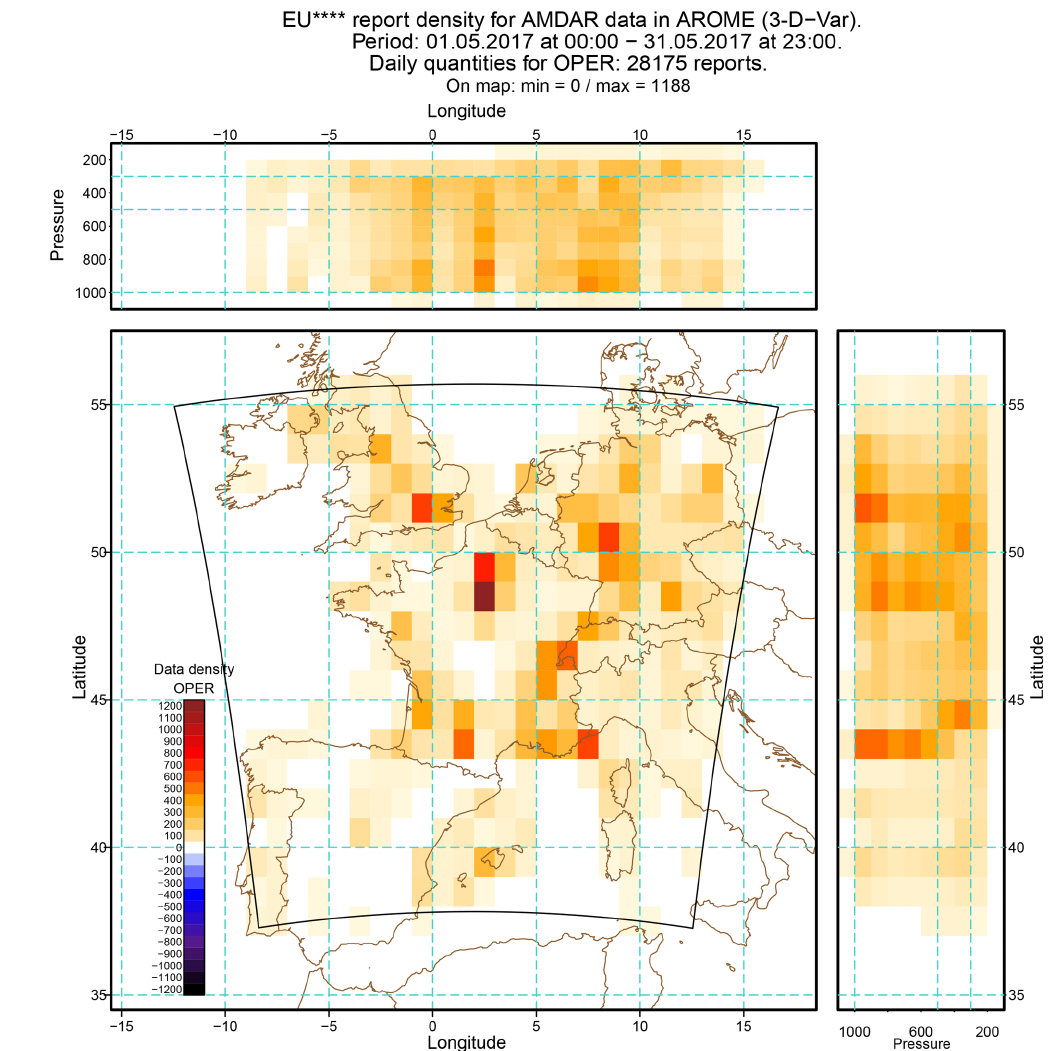
Figure 2. Map and vertical cross-sections of E-AMDAR data density for the operational suite in May 2017. The density is computed using 1 ◦ × 1 ◦ geographical bin. For vertical cross-sections, bins are 1 ◦ × 100hPa. Top panel shows a longitude-pressure cross-section, right panel is a pressure-latitude view. The black line frame highlights the geographical extent of the AROME-France